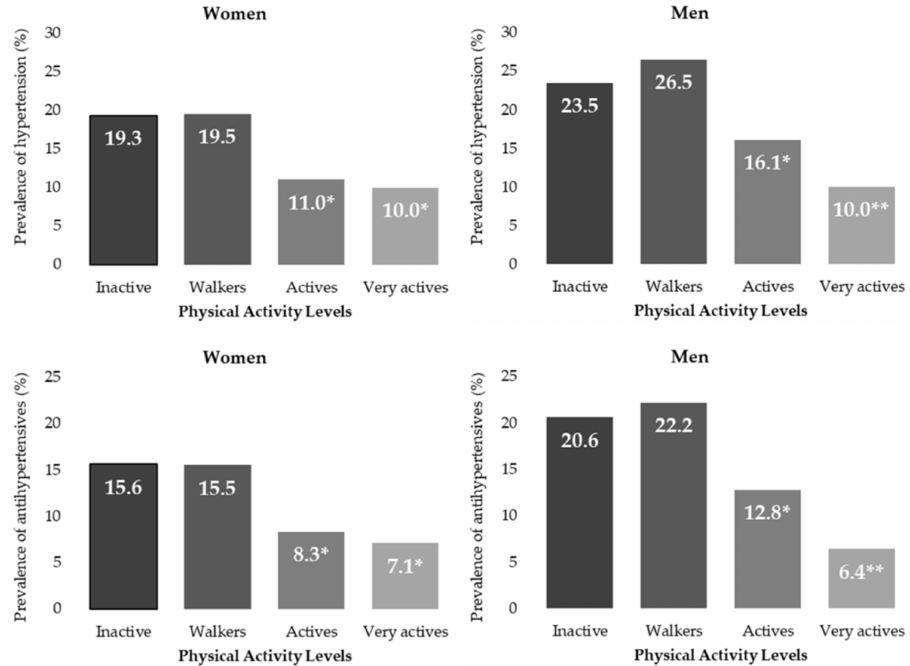
Figure 1. Prevalence of hypertension and use of antihypertensive drugs by PAL and sex. */** (One star shows significant differences in prevalence of hypertension/antihypertensives with respect to no star and two star values. Two stars show significant differences with no star and one star values. p < 0.05 from